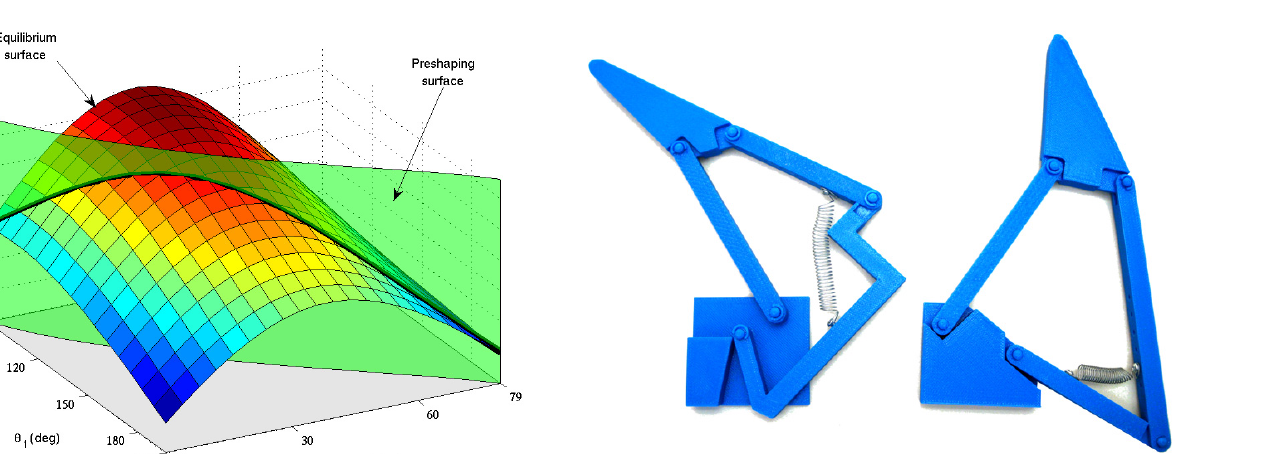
Figure 13. Equilibrium surface of the optimal design of two- phalanx finger with anthropomorphic preshaping.